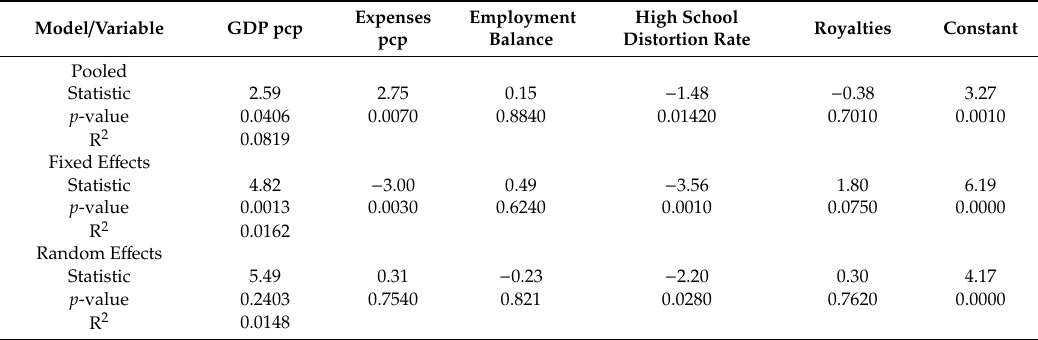
Table 7. Economic development model.